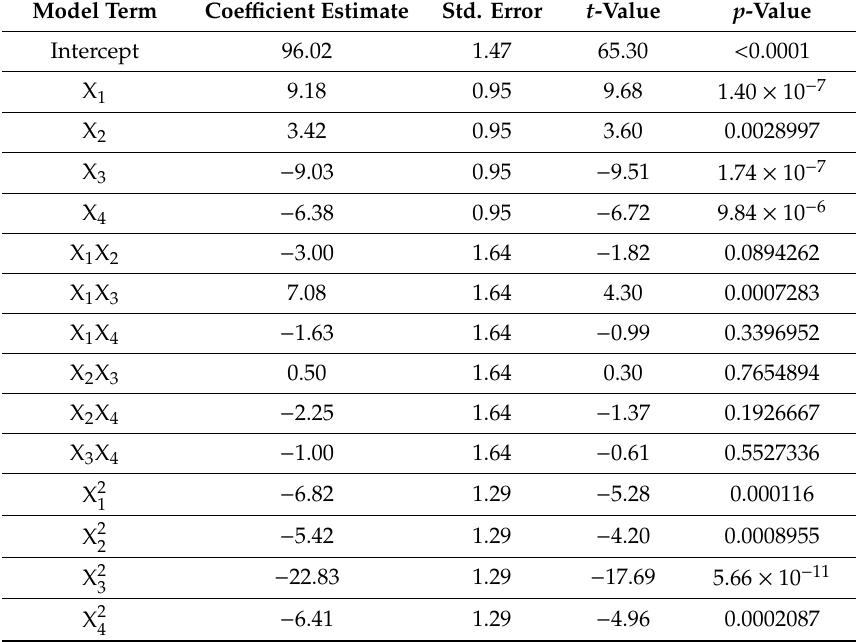
Figure 3. Experimental versus predicted removal values for CIP adsorption onto ZIF-67-SO 4 . Table 5. Estimated coe ffi cients of the fitted polynomial model for CIP adsorption onto ZIF-67-SO 4 . Model Term Coe ffi cient Estimate Std.